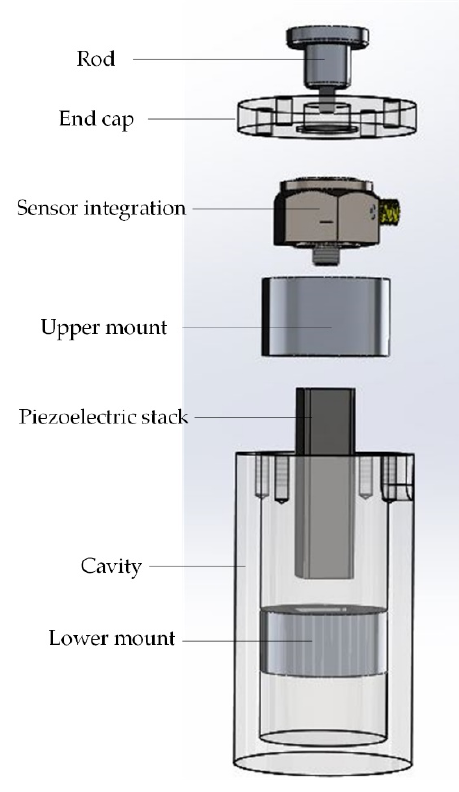
Figure 1. The structure of the piezoelectric sensor-actuator.